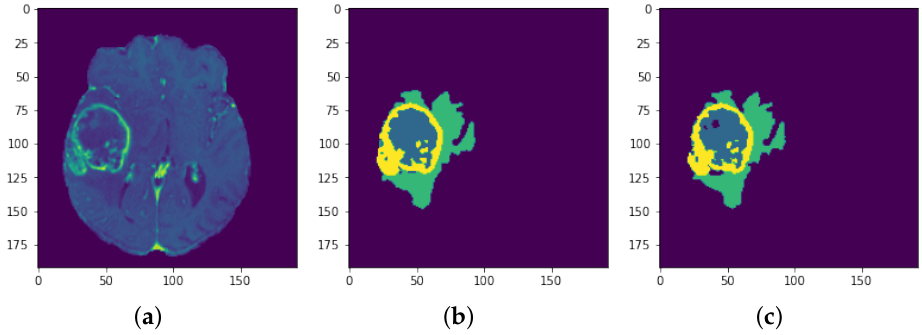
Figure 32. Results: Slice 5: ( a ) Slice ( b ) Predicted result ( c ) Actual result.